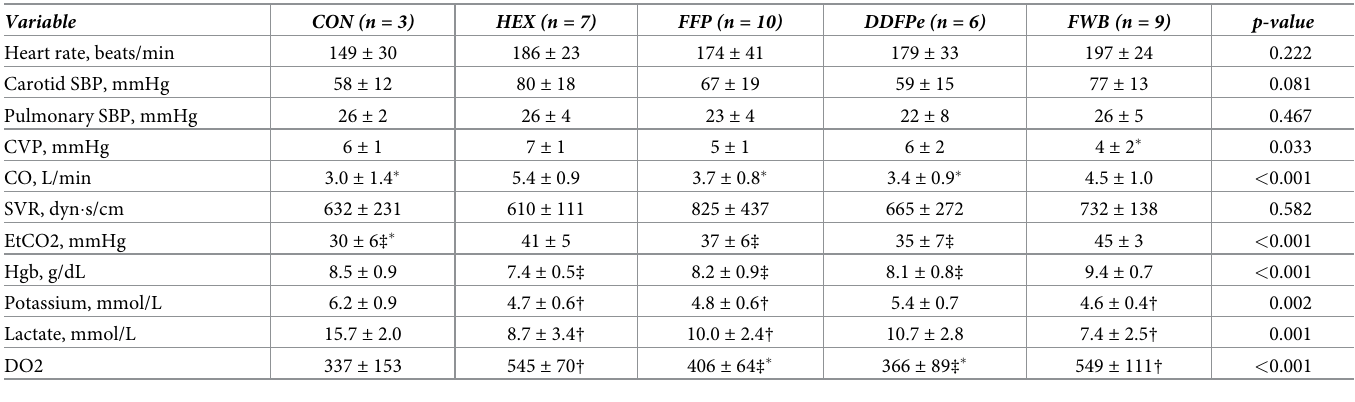
Table 1. Physiologic parameters at 60-minutes.